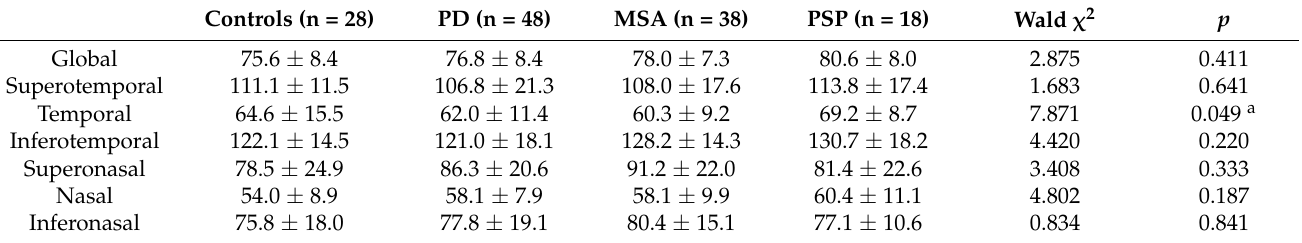
Table 4. Comparisons of peripapillary retinal nerve fiber layer thickness ( µ m) between different groups (4.7 mm